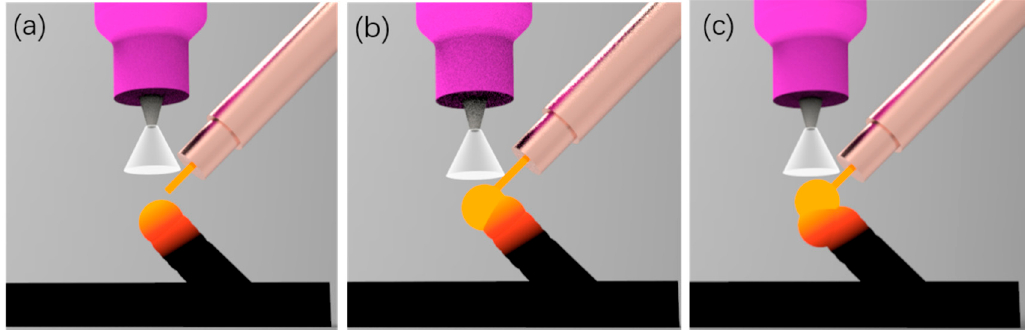
Figure 9. Schematic of manufacturing process with too-low layer height. ( a ) wire feeding; ( b ) peak time; ( c ) the droplet is squeezed and bent.